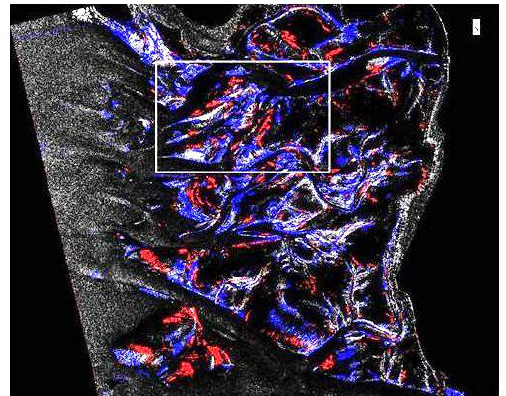
Figure 8. Temporal coefficient based on two Radarsat-2 SAR